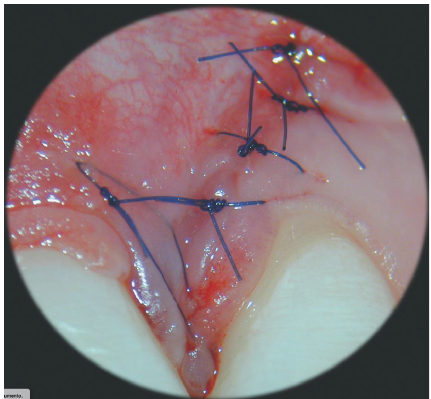
Figure 5: Detail of the sutures placed for vertical incisions.